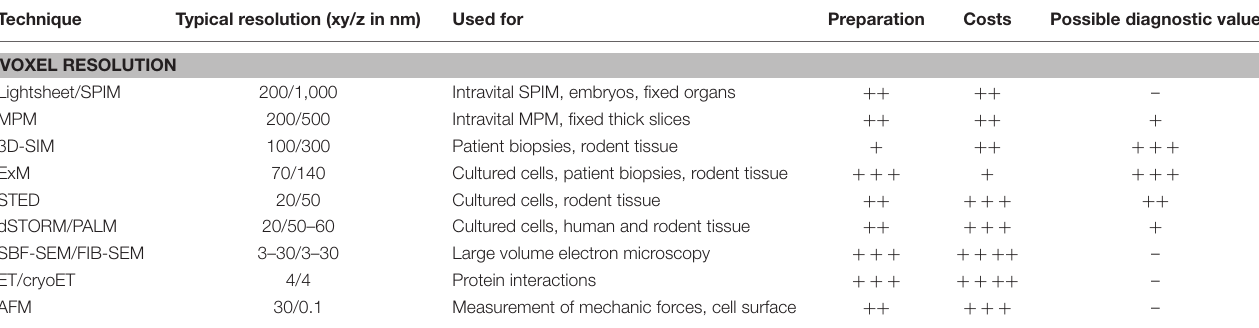
TABLE 1 | Comparison of the different techniques discussed above. Technique Typical resolution (xy/z in nm) Used